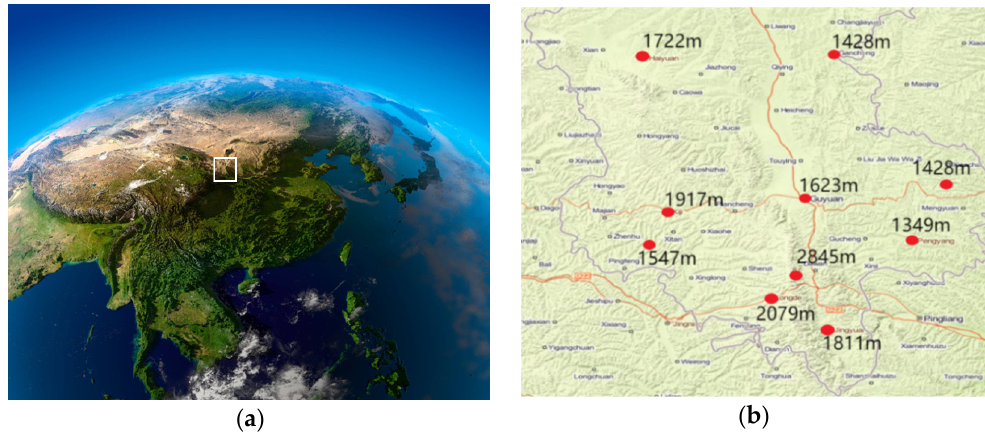
Figure 1. Aerial view map of the general region. ( a ) The position of the LPM area (The area in the white circle). The base map is obtained from Google Maps; ( b ) Diagram of location distribution of 10 GNSS/MET stations in the LPM area (Red spots). The base map is obtained from the National Platform for Common Geospatial Information Services of China.